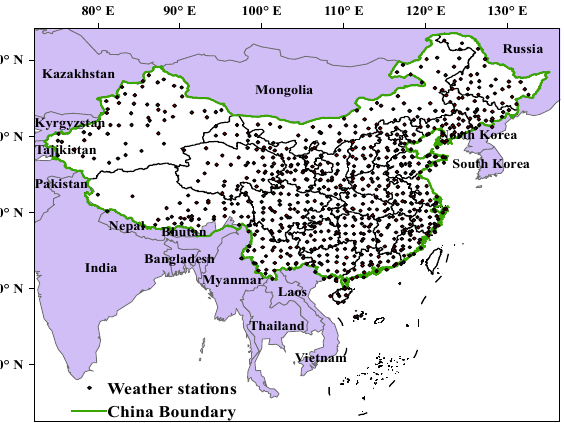
Figure 1. Study area. Black dots represent weather stations and the green solid line represents China boundary.